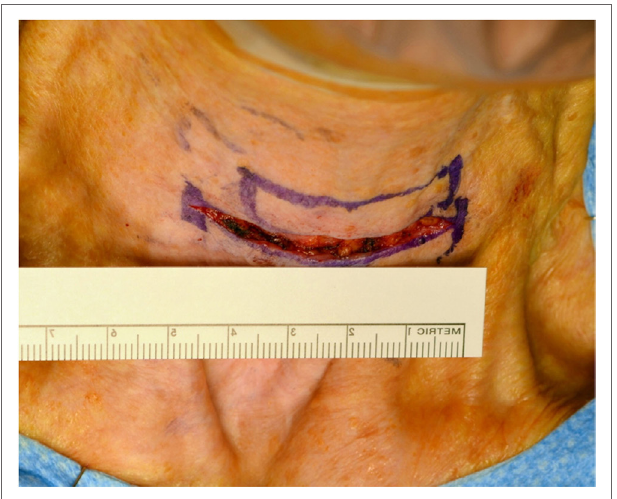
FigUre 3 | Exposure of larynx in a case after horizontal laryngectomy. Note the freeing of the pyriform sinus on the right (arrow).